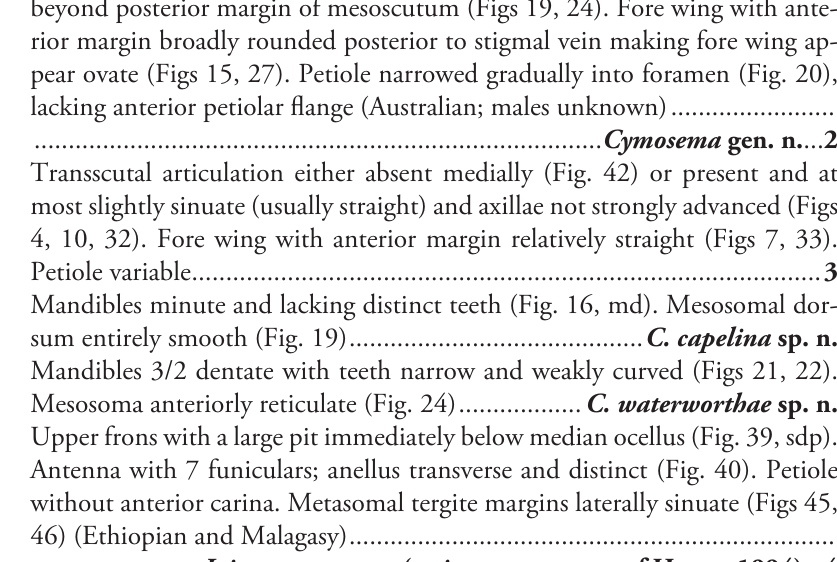
Antenna with 7 funiculars; anellus transverse and distinct (Fig. 40). Petiole without anterior carina. Metasomal tergite margins laterally sinuate (Figs 45, 46) (Ethiopian and Malagasy) .......................................................................